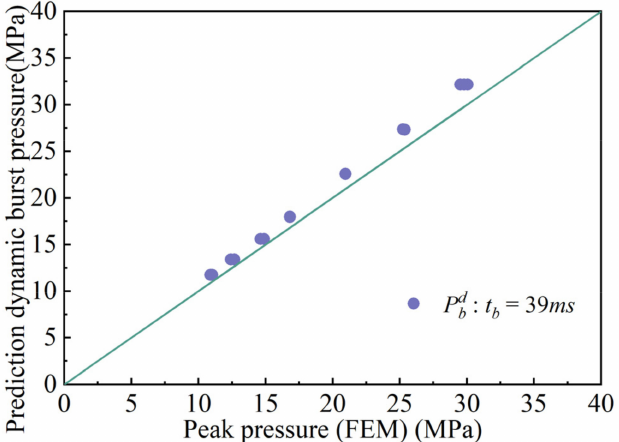
Figure 8. Comparison results with pulse duration t d = 39ms.